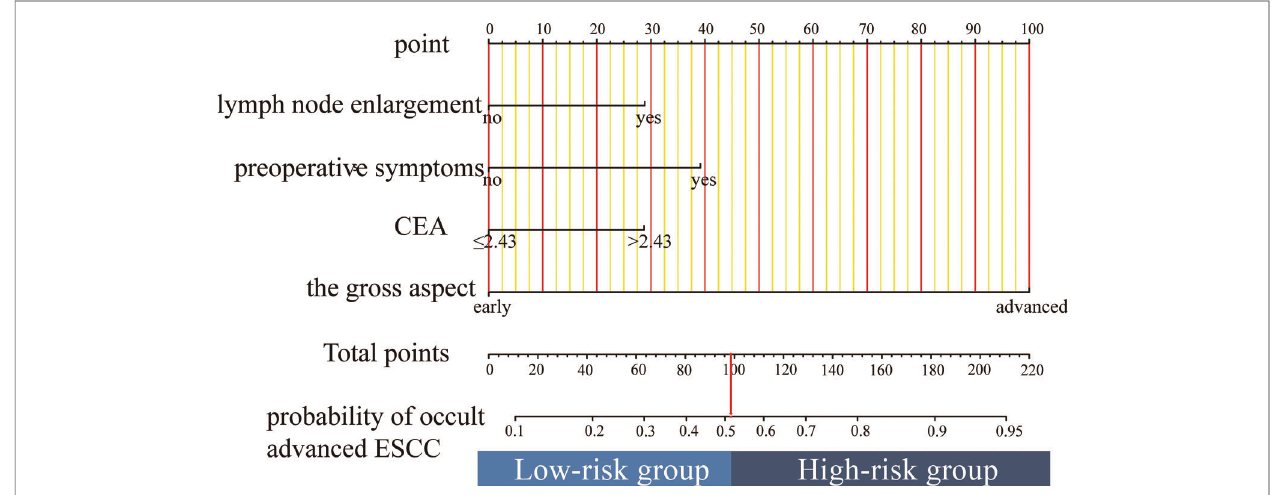
FIGURE 2 | To use the nomogram, fi nd the position of each variable on the corresponding axis, draw a line to the points axis for the number of points, add the points from all of the variables, and draw a line from the total points axis to determine the occult advanced ESCC probabilities at the lower line of the nomogram.